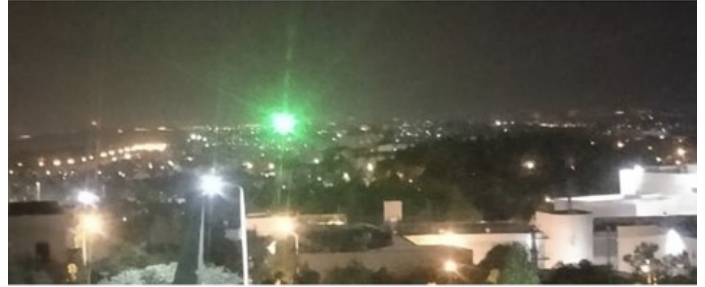
Figure 7. Terrestrial laser-beacon detection and tracking. A 0.002 Watt green laser as captured from ∼ 9 km by a basic Raspberry Pi camera in VGA